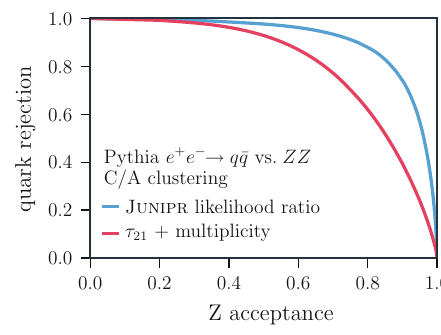
bution using 2-subjettiness and constituent multiplicity. All jets used in this study have masses between 90.7 and 91.7 GeV